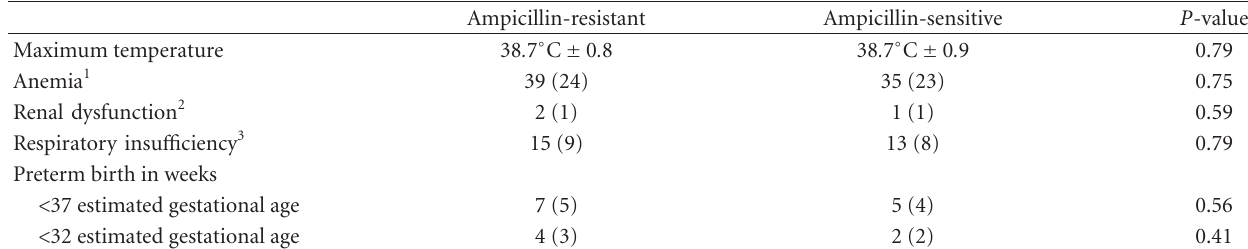
Table 5: Comparison of hospital courses of women with ampicillin-resistant versus ampicillin-sensitive uropathogens in acute antepartum pyelonephritis . Data are reported as n (%) or mean ± standard